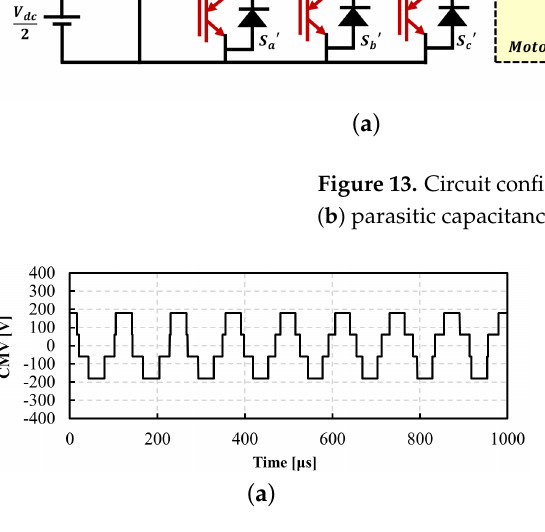
Figure 14. Simulated common-mode voltage waveform at ( a ) 360 V and ( b ) 600